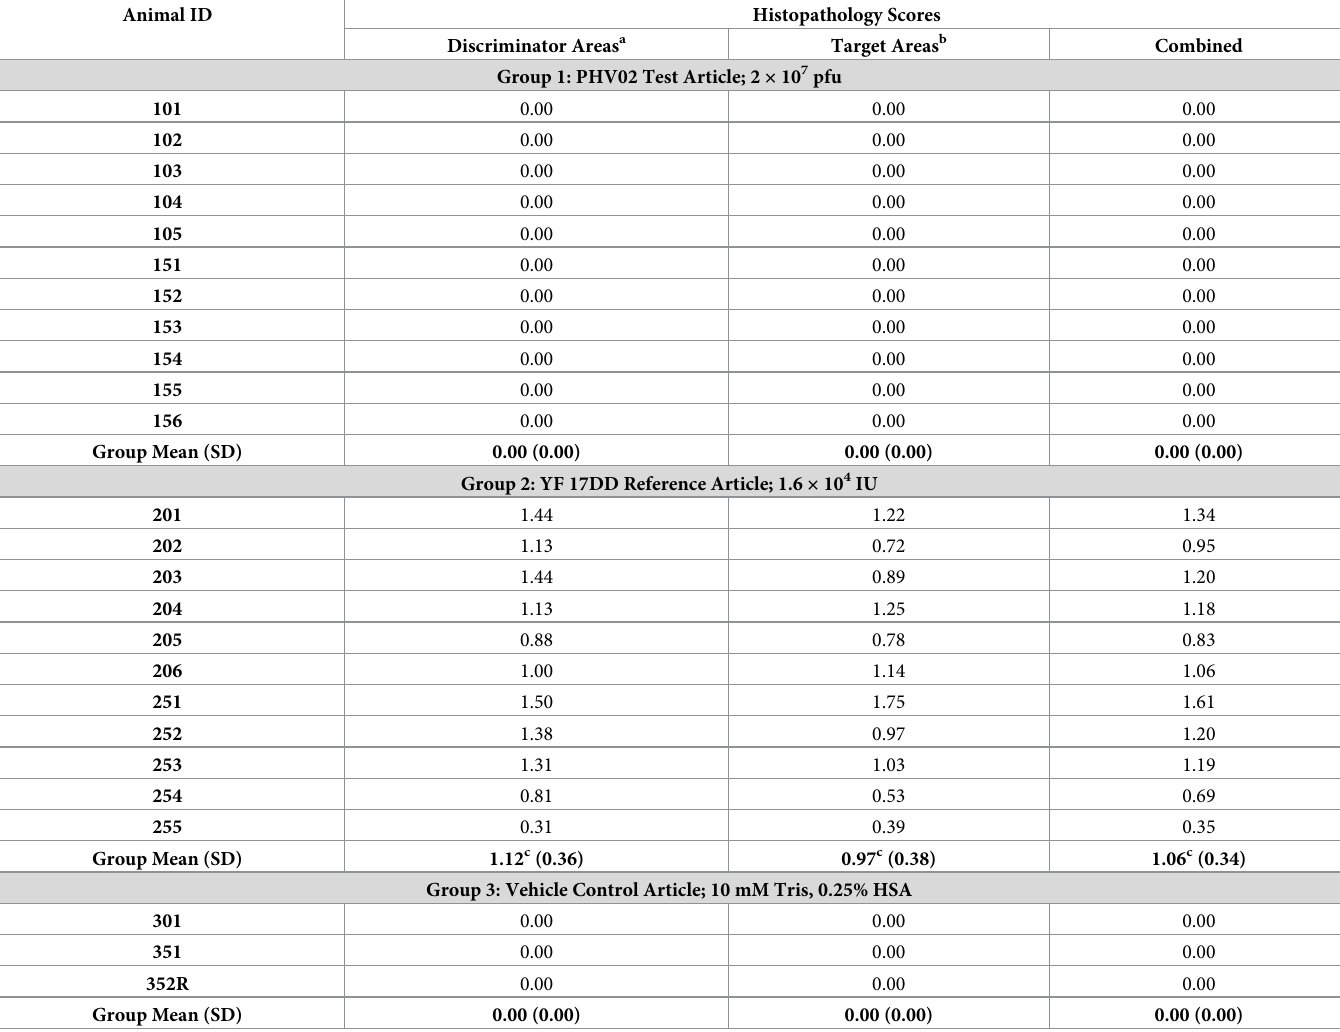
Table 3. Discriminator, Target, and Combined Scores, Cynomolgus Macaques, Neurovirulence Test, evaluated 30 days after inoculation. Animal